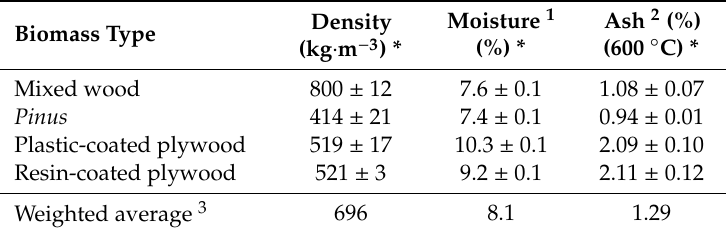
Table 2. Density, moisture, and ash content by